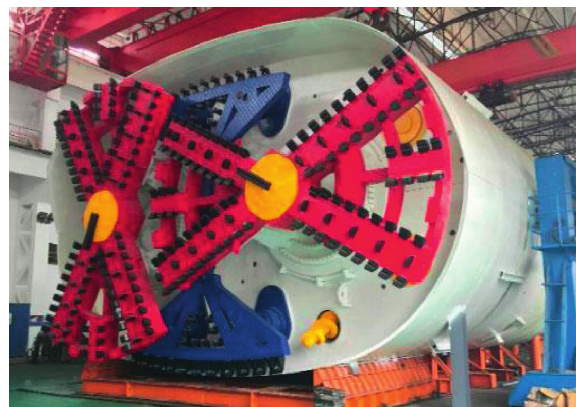
Figure 1: Actual quasirectangular shield machine. Large cutterhead